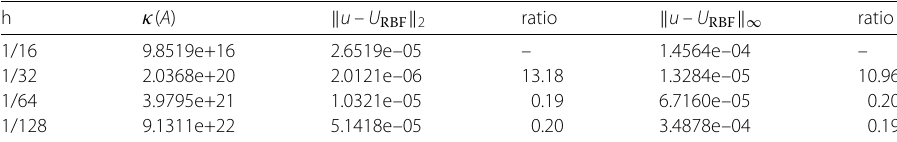
Table 3 The errors for the RBF collocation method in two norms h